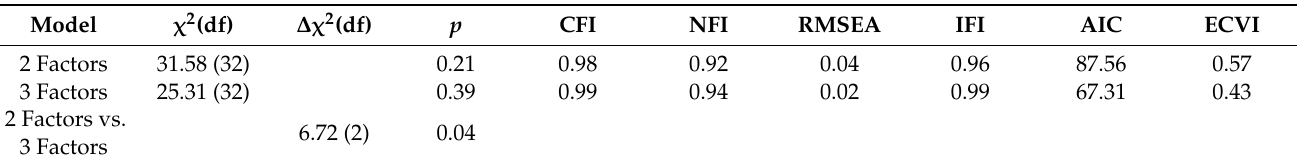
Figure 3. Confirmatory factor analysis of G-MISS-HP; 3-factor model. Note. Values on paths correspond to standardized estimates. Table 7. Fit indices and chi-square difference tests for two different models (two-factor models vs. three-factor models).